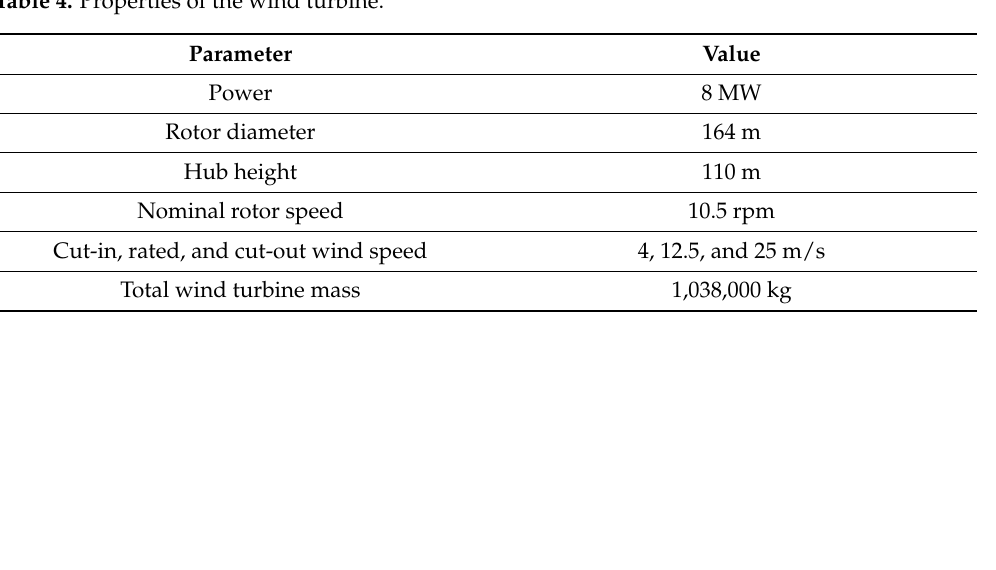
Table 4. Properties of the wind